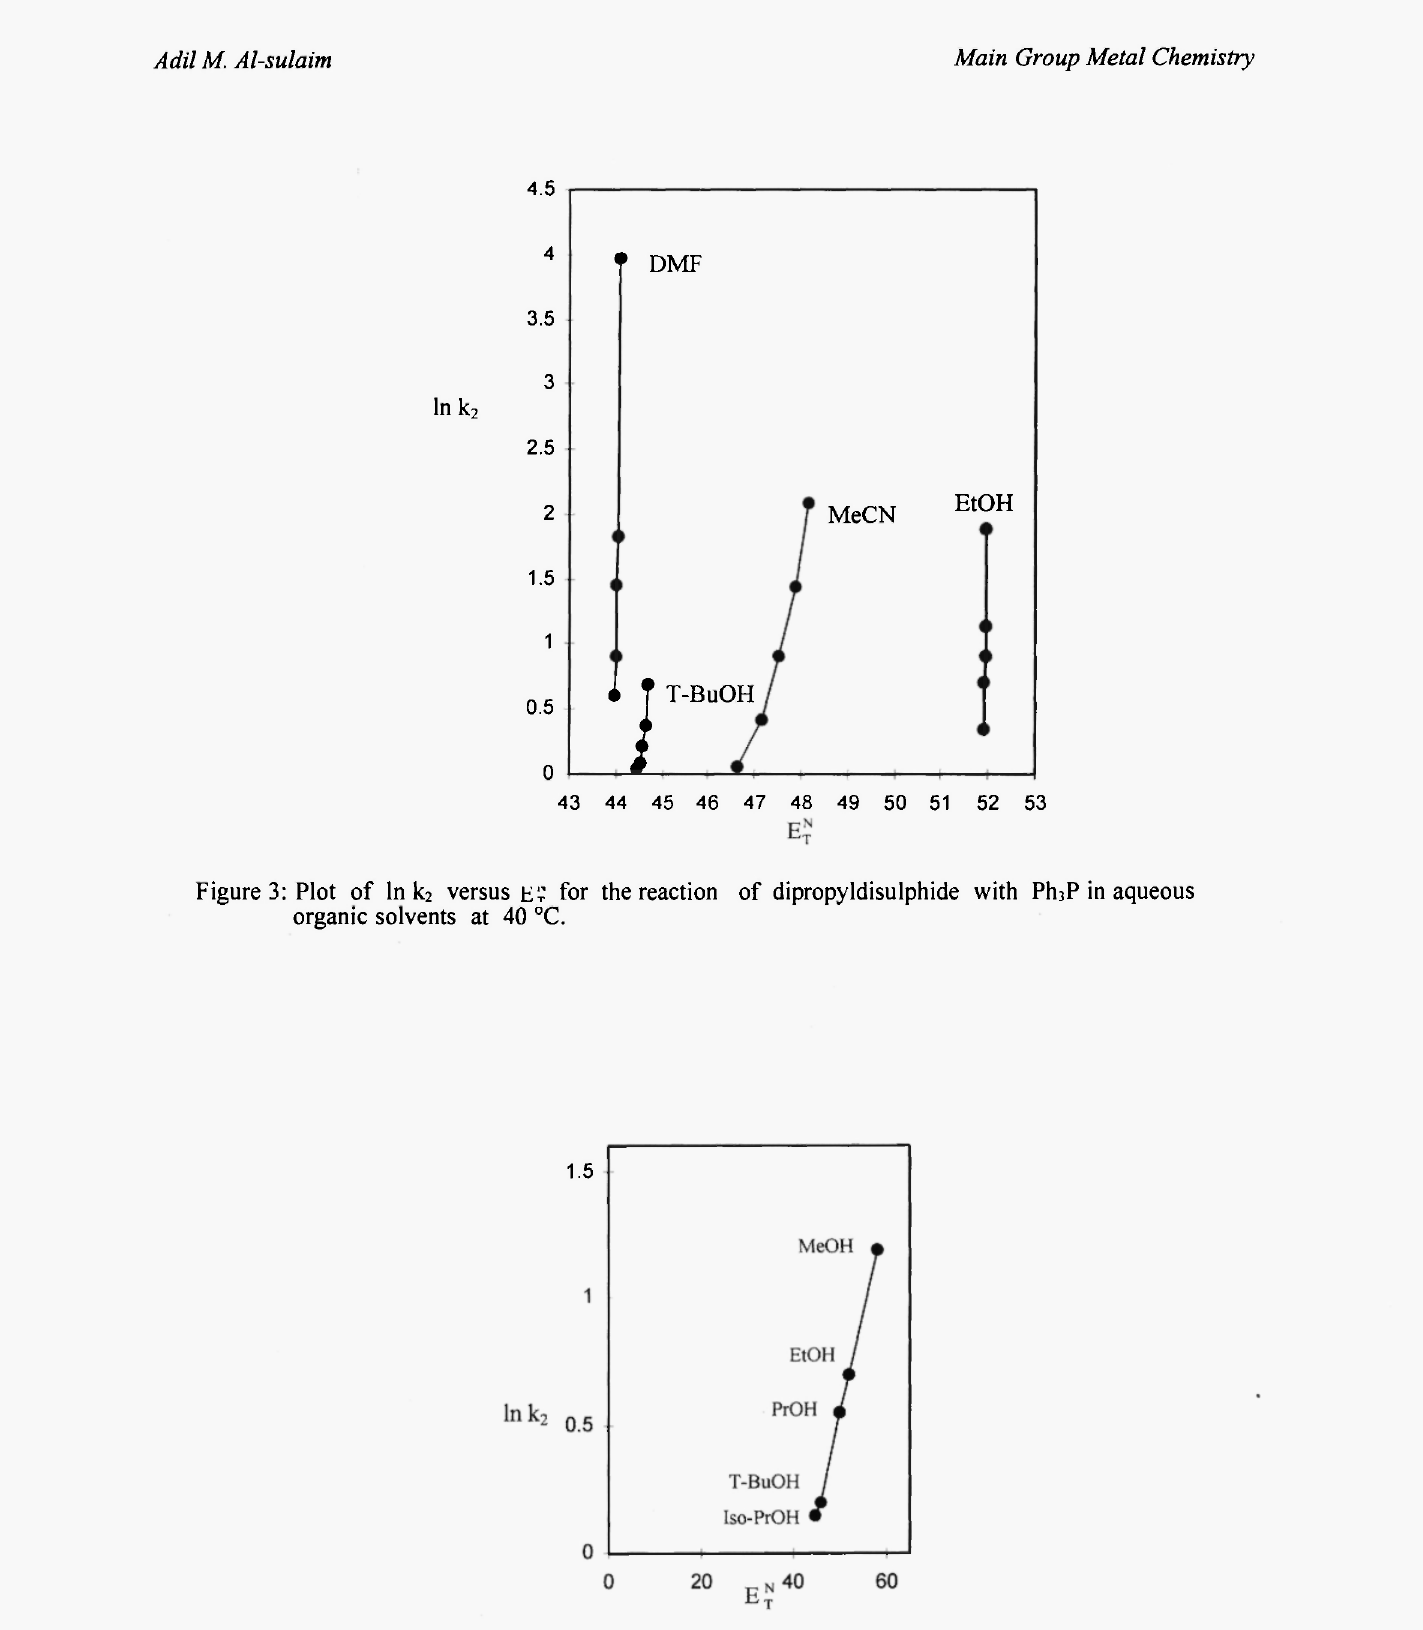
Figure 4: The variation of In k 2 ' so with h T ' at constant dielectric constant (ε =40) for the reaction of dipropyl disulphide with triphenylphosphine in aqueous organic solvents at 40